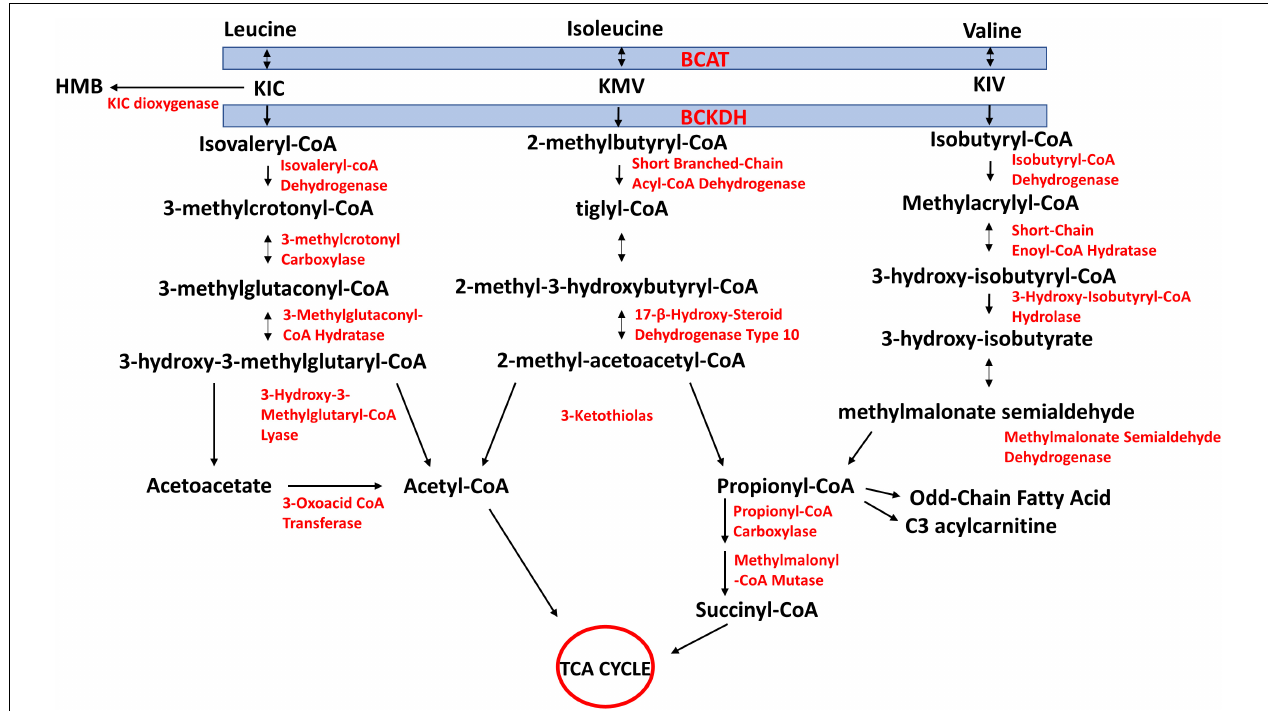
FIGURE 2 | Schematic of branched-chain amino acid (BCAA) catabolism. BCAAs share the same first two steps in their catabolism. They undergo reversible transamination, catalyzed by mitochondrial or cytosolic isoforms of branched-chain aminotransferase (BCAT). Branched-chain ketoacids (BCKAs) produced from this reaction are irreversibly decarboxylated to yield respective CoA compounds, which divide into their respective metabolic pathways. KIC, 2-keto-isocaproate/4-methyl-2-oxopentanoic acid; KMV, α -keto- β -methylvaleric acid/3-methyl-2-oxopentanoate; KIV, 2-keto-isovalerate/3-methyl-2-oxobutanoic acid. Re-drawn and modified from Adeva-Andany et al.